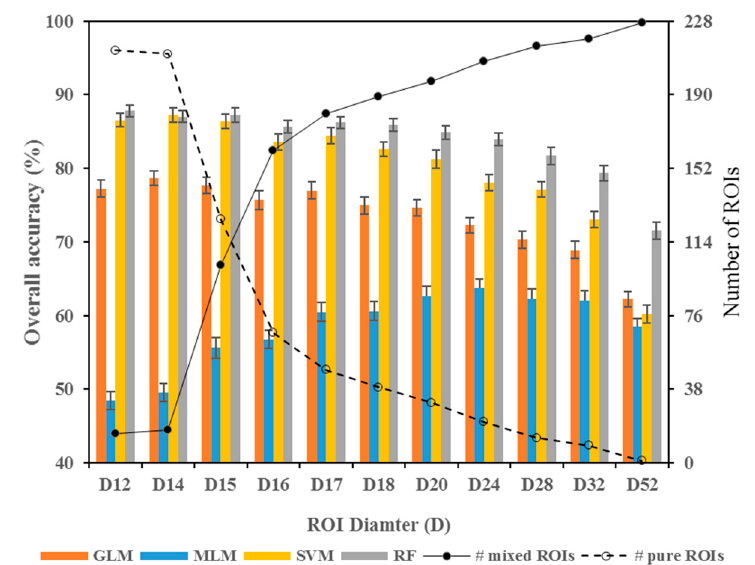
Figure 4. Overall accuracy and 95% confidence interval results by classifier type, by ROI size and the associated proportions of pure and mixed ROIs for the 228 sites in this study. Note: ROI = region of interest, GLM = Generalized Linear Model, MLM = Multinomial Logistic Model, SVM = Support Vector Machine, and RF = Random Forest.